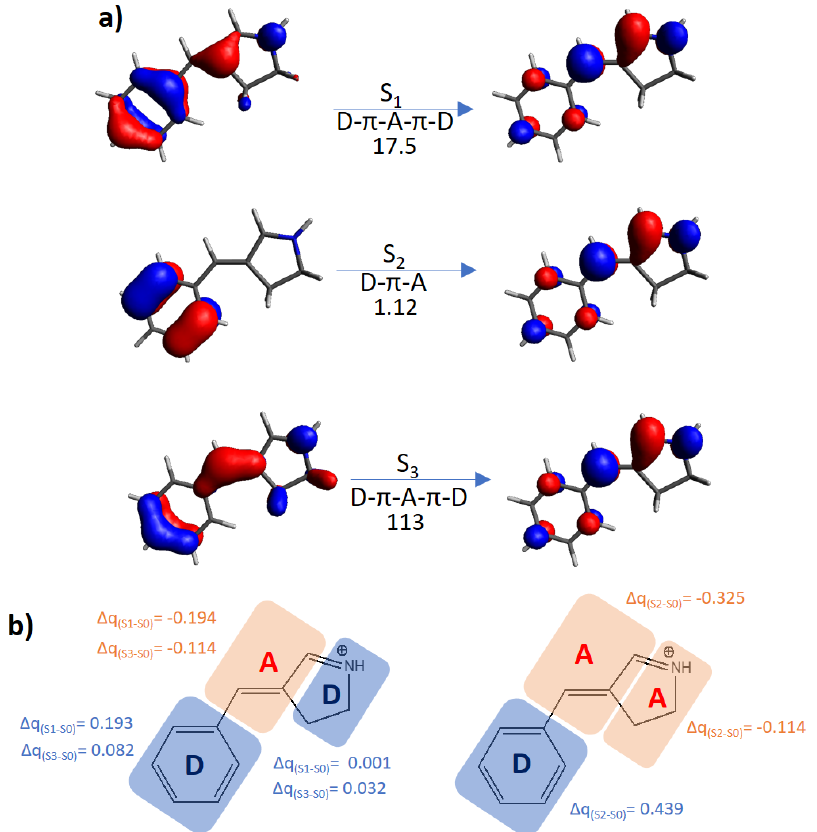
Figure 4. ( a ) Molecular orbitals mainly involved in the lowest-in-energy optical transitions (S 0 → S 1,2,3 ) for the E form of the protonated Schiff-base. The type of electronic transfer (from the lateral moieties to the central one (D- π -A- π -D); from the six-membered ring to the five-membered ring (D- π -A)) and the σ TPA value in GM are given below each arrow. ( b ) Molecular moieties assigned as donor D or acceptor A. On the left, it is shown the D- π -A- π -D structure, on the right the D- π -A structure, with the relative charge transfer among excited and ground states ( Δ q).